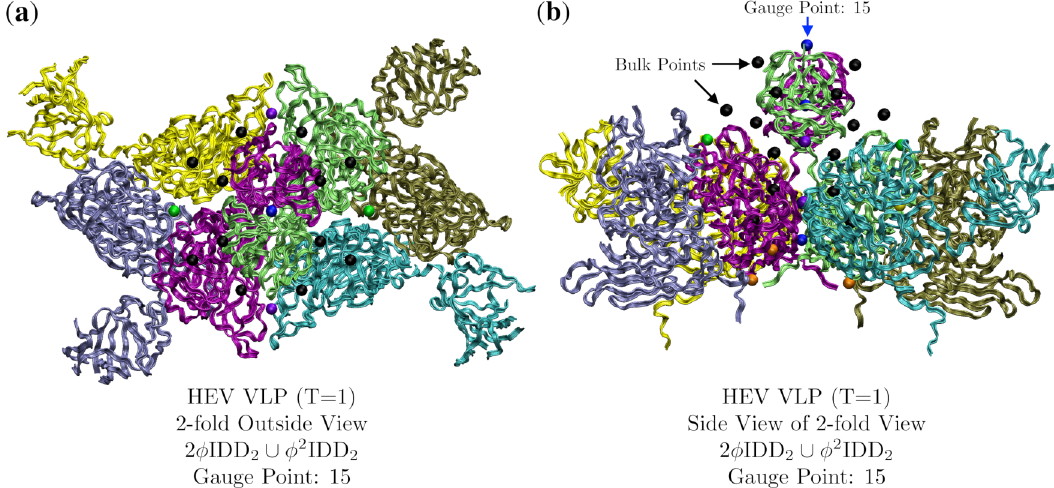
Figure 14. Exhibiting the point array description of Hepatitis E virus-like particle ( T = 1, 3hag [19]) using a ribbon view with each protein colored separately. In ( a ) we are viewing down a 2-fold axis, the gauge point is 15 (blue) on the 2-fold axes. We can see the many point array elements nestled in and around the protein surface. In ( b ) we are looking at the same section from the side view, and you can see how the proteins fit neatly between the point arrays. The lowest radial points (orange) were added by φ 2 IDD 2